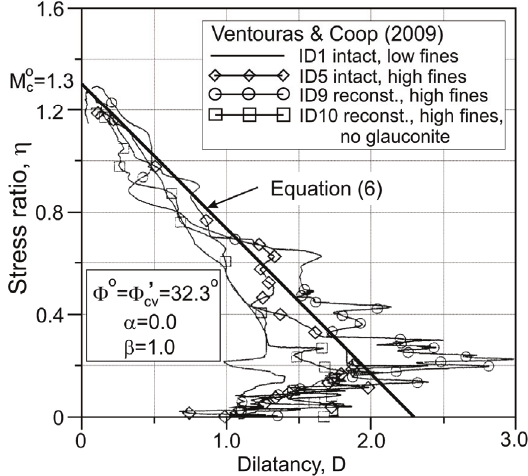
Fig. 6. Stress-dilatancy relationship for Thanet